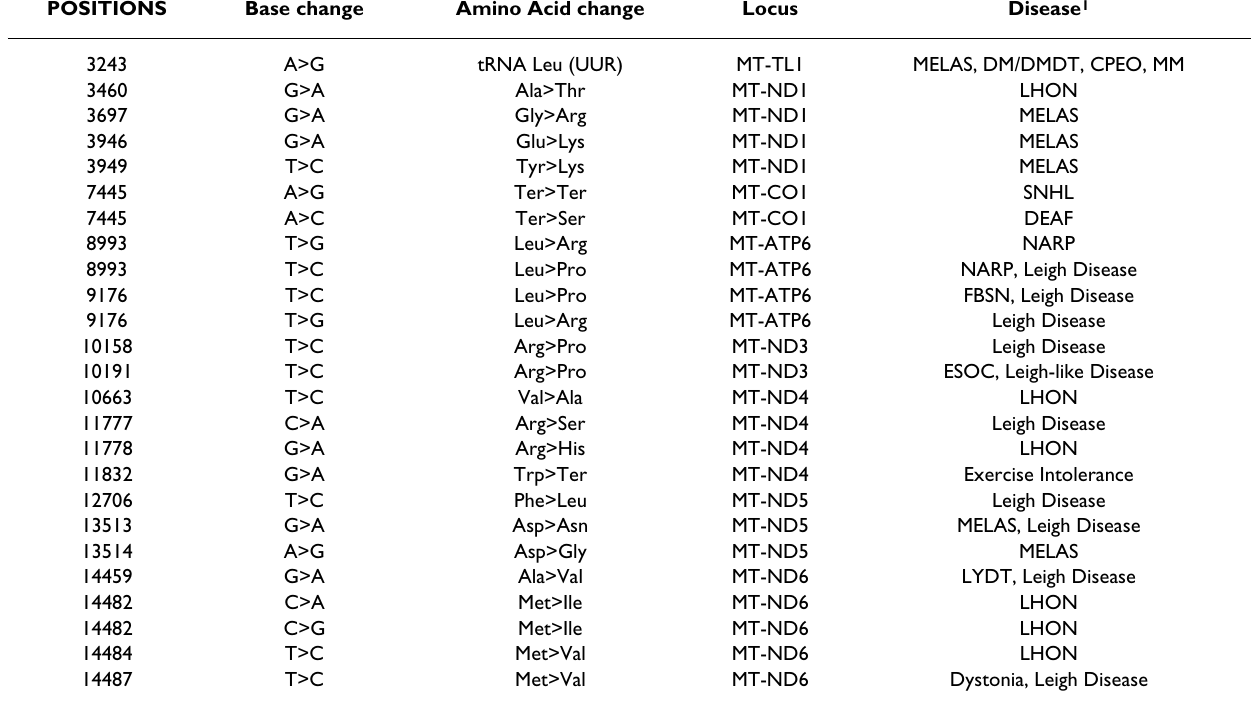
Table 1: Characteristics of the mutations incorporated in our multiplex design